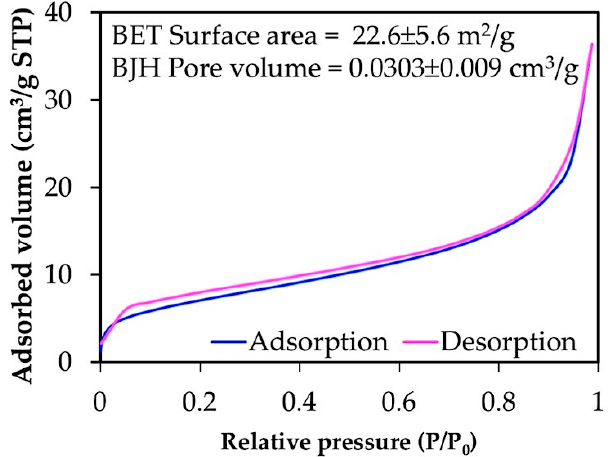
Figure 9. Brunauer-Emmett-Teller (BET) isotherm of freeze-dried microgels prepared under of 3 % w / w chitin solution, O:W = 15:1, 5% w / w Span 80 (HLB 4.3), and gelation by 800 µ l of 1.0 M conditions of 3 % w/w chitin solution, O:W = 15:1, 5% w/w Span 80 (HLB 4.3), and gelation by 800 μ l of 1.0 M HCl.